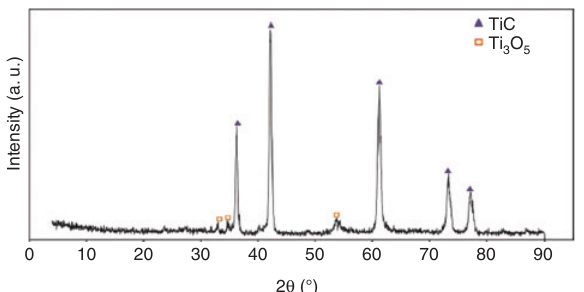
Figure 7: X-ray Diffractometry Micrographs of Titanium Carbides Synthesized at 1300 °